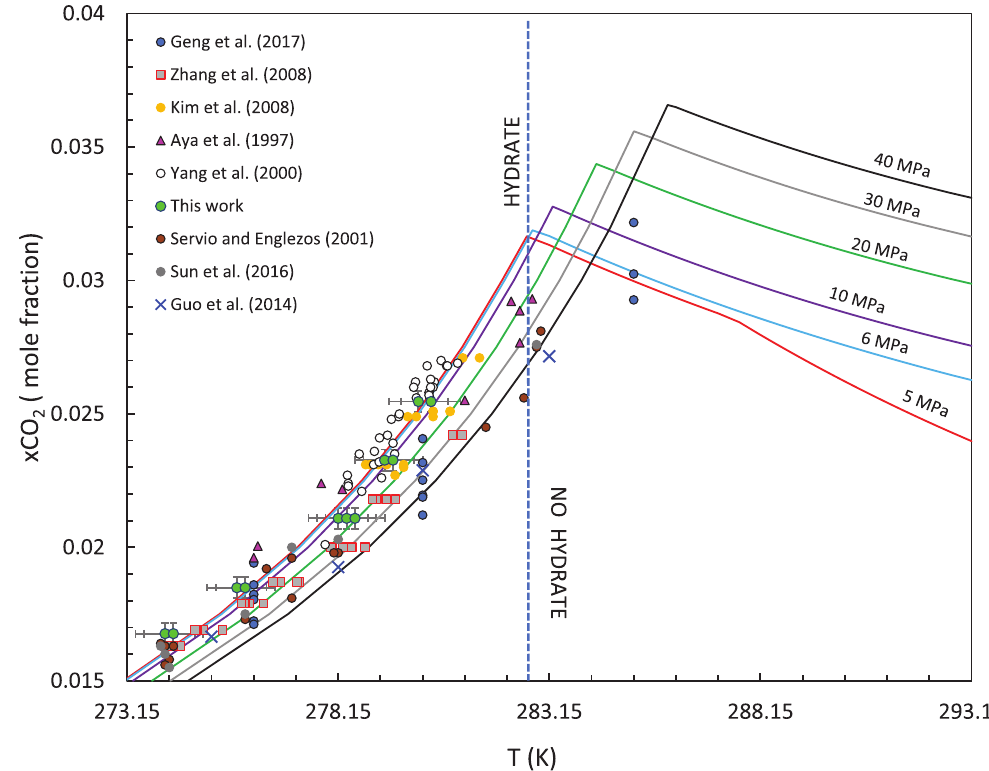
Fig. 7. Comparison of experimental and predicted solubility of CO 2 in water at H – L w and V – L w